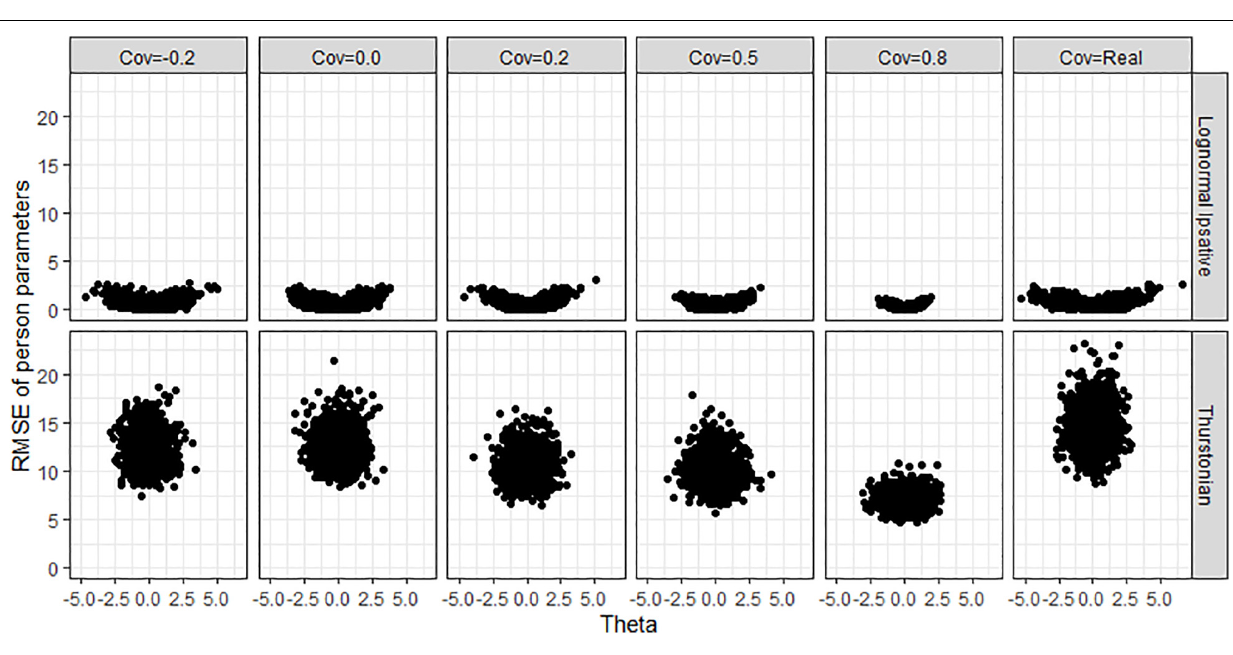
corresponded to the result of empirical data analysis in this